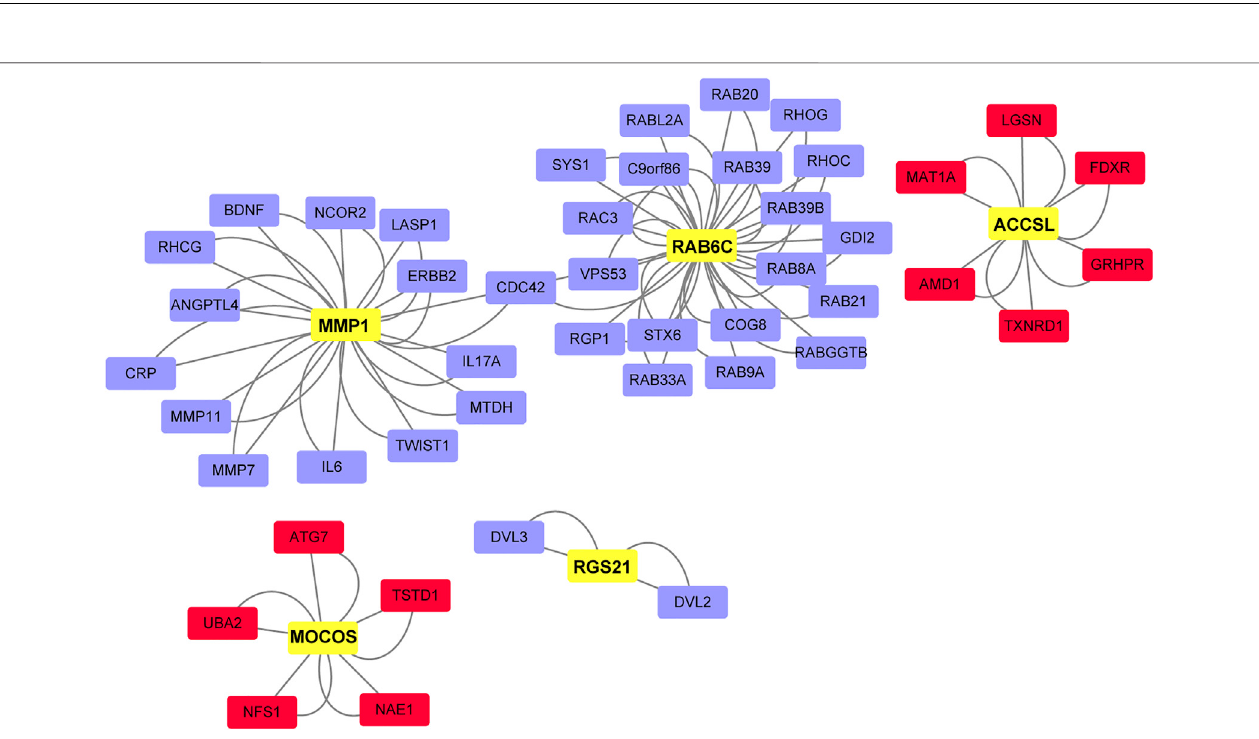
FIGURE5 | Network ofkey DLBCL drivers and hub genes. Red, keydrivers from up-regulated gene set inadvanced-stage samples.Blue,key drivers from down- regulated gene set in advanced-stage samples. Yellow, hub genes.